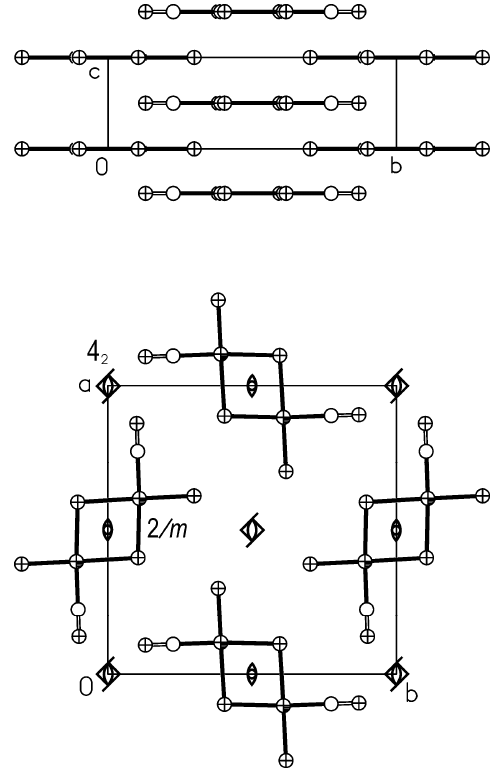
Figure 3. The crystal structure of trans -Pt the a (top) directions. Some symmetry operators are reported.